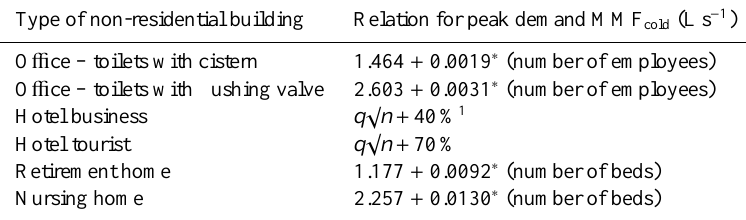
Table 1. Old guidelines for maximum momentary flow of cold water in various non-residential buildings (Sche ff er,